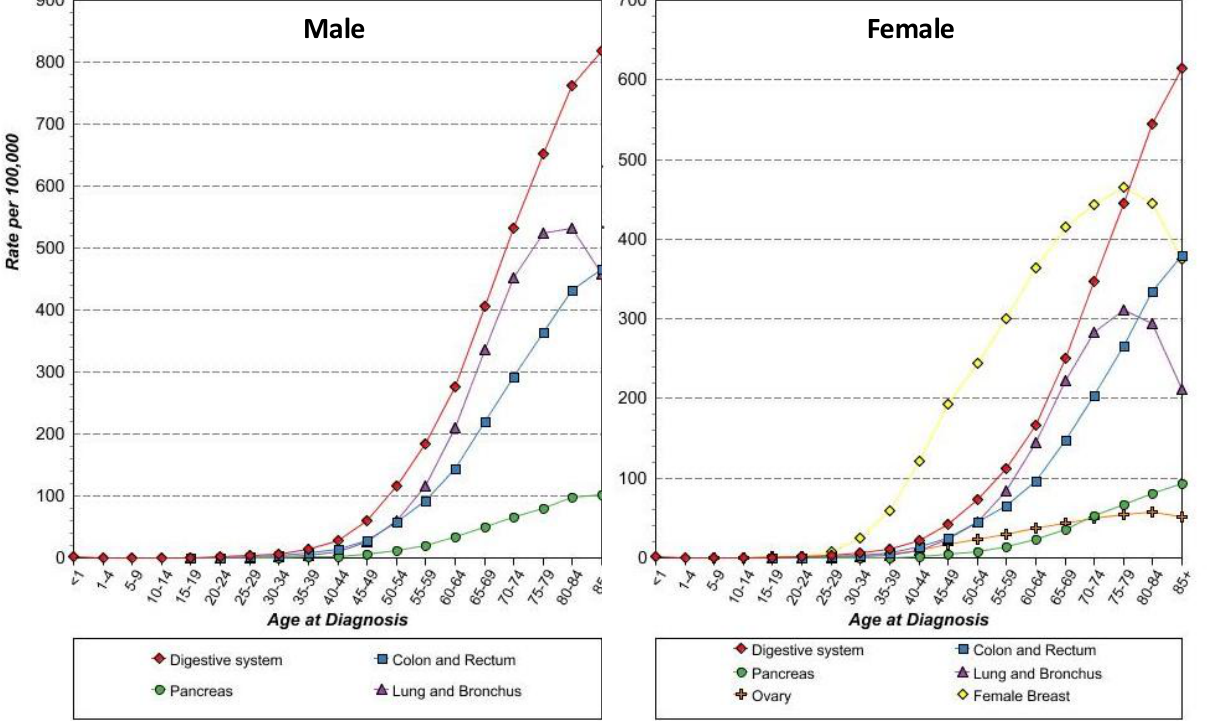
Figure 6. Age-specific (crude) SEER incidence rate by cancer sites. All ages, all races, 1992-2009. Male